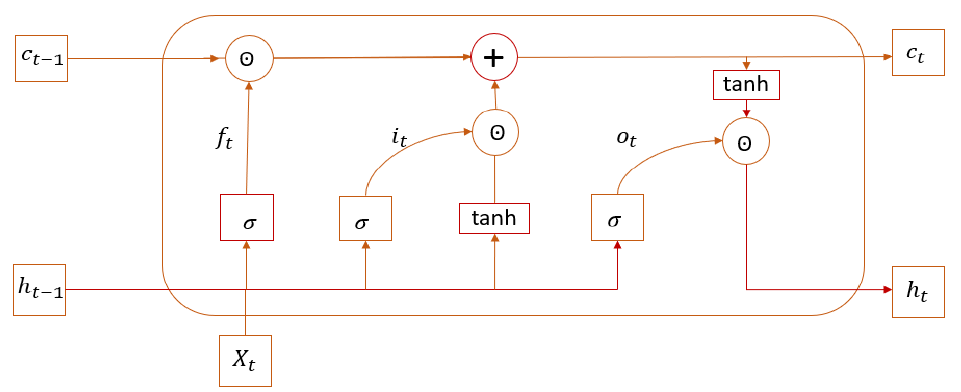
Figure 2. LSTM cell architecture. Adapted from reference [68].